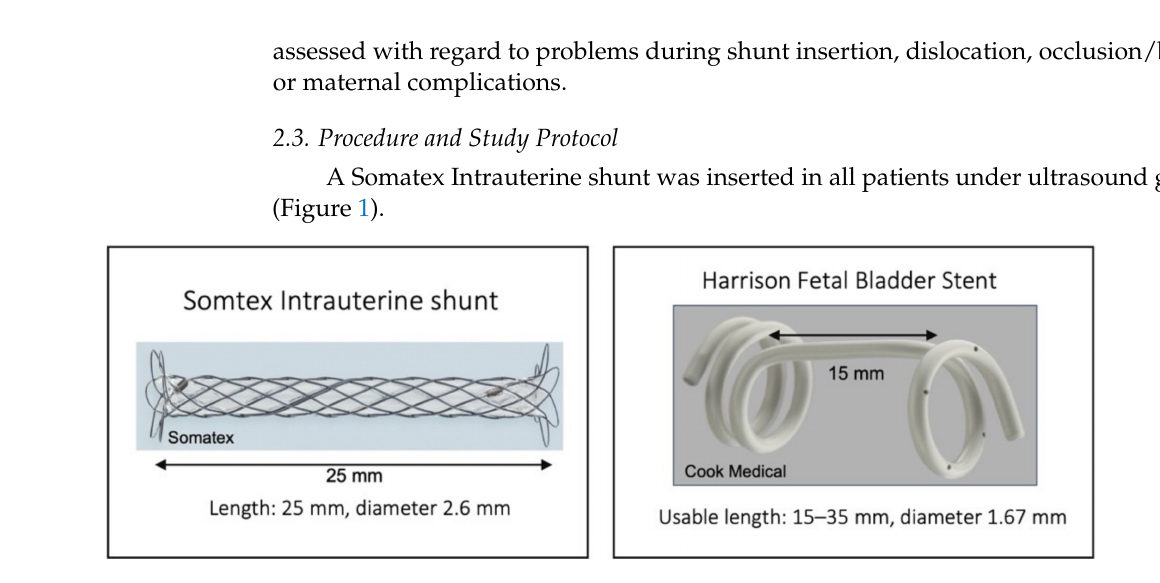
Figure 1. Shunt types used for thoracoamniotic